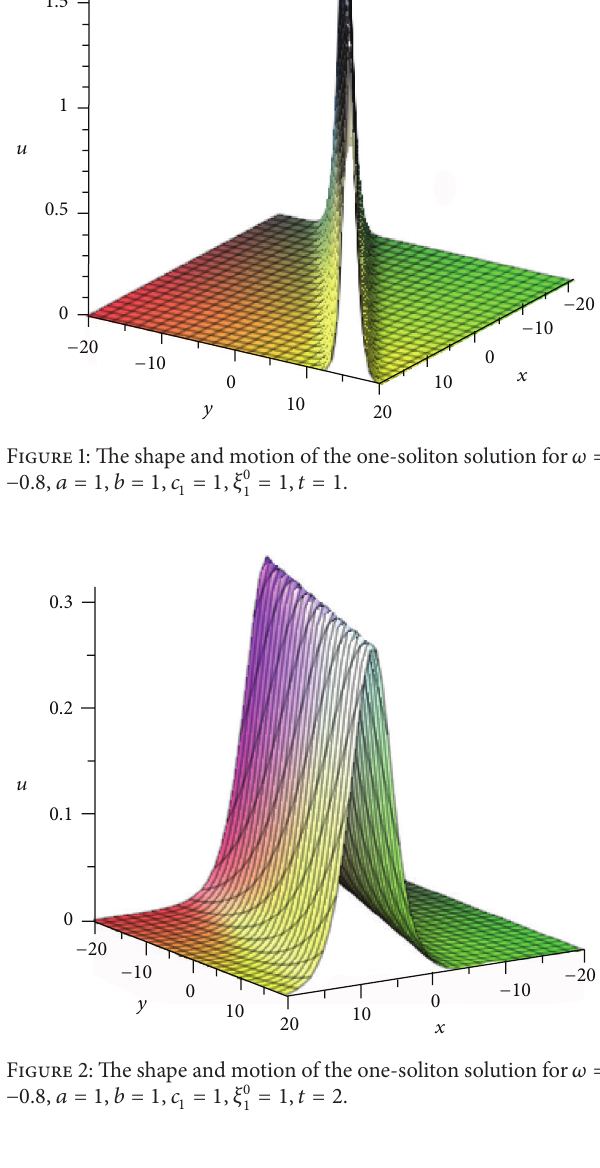
= 1 , 𝜉 0 = 1 , 𝑡 = 2 . 1 1